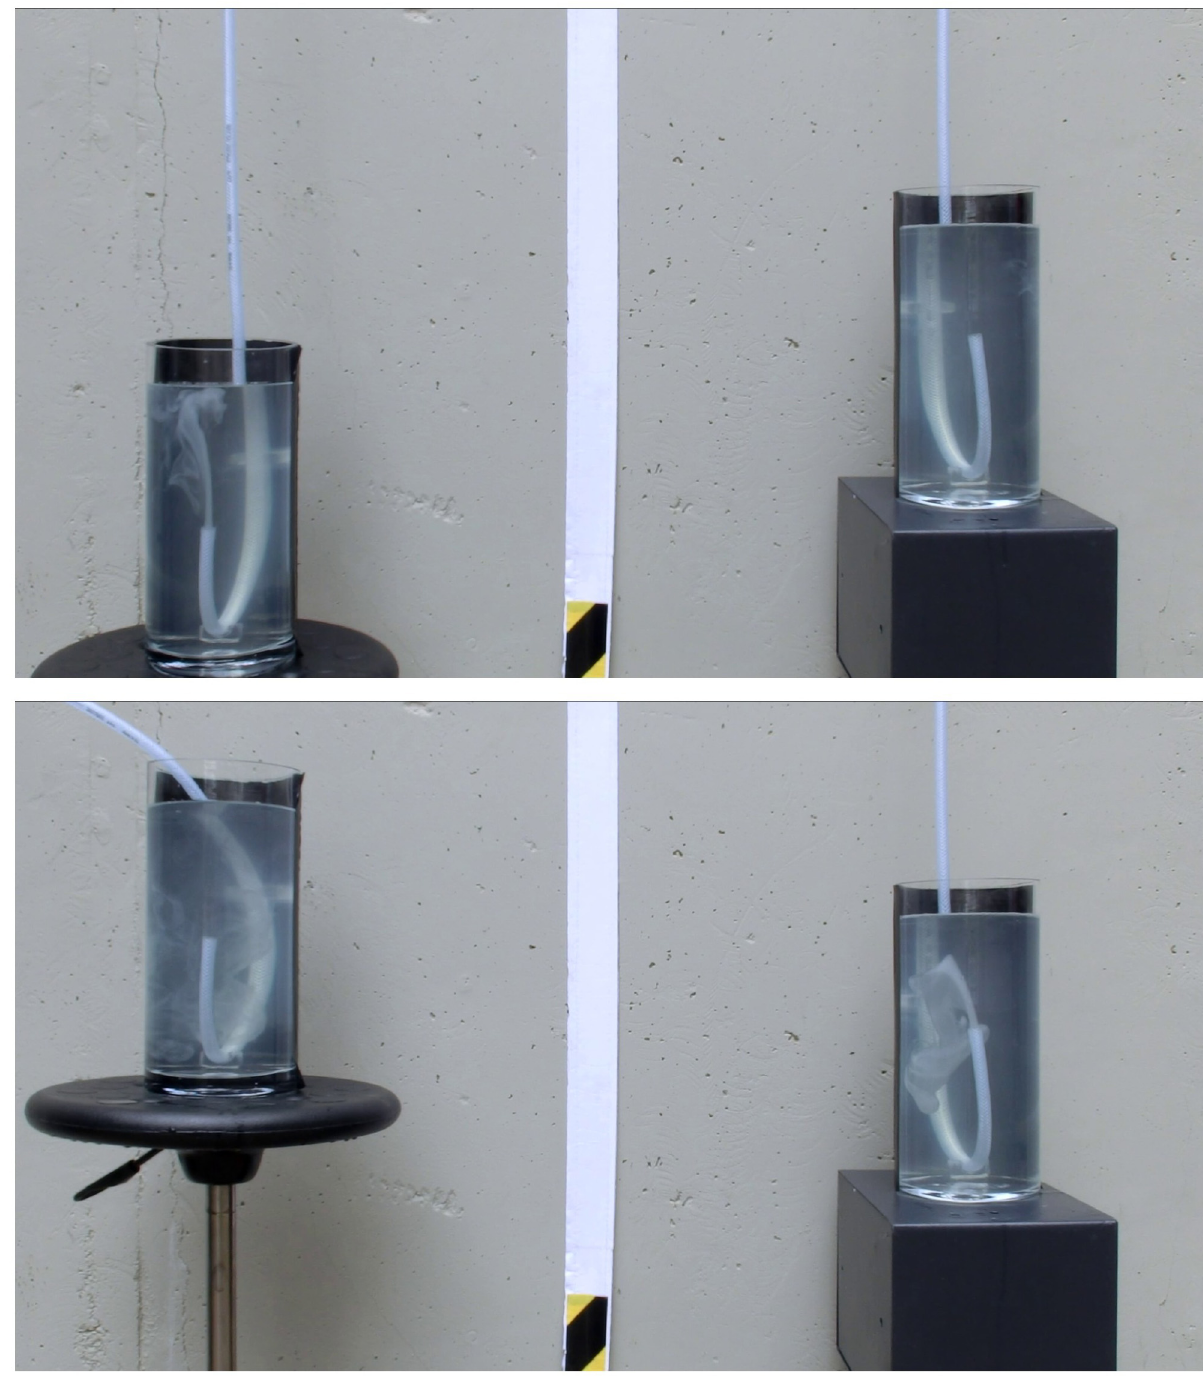
Fig 5. A closeup of the 15.4 m siphon during operation. The upper panel shows water being siphoned from the right container to the left container. The lower panel shows the same experiment after exchanging the heights of the containers and when water was moving from the left container towards the right container. A movie of this experiment is available as supplementary material in the online version of the